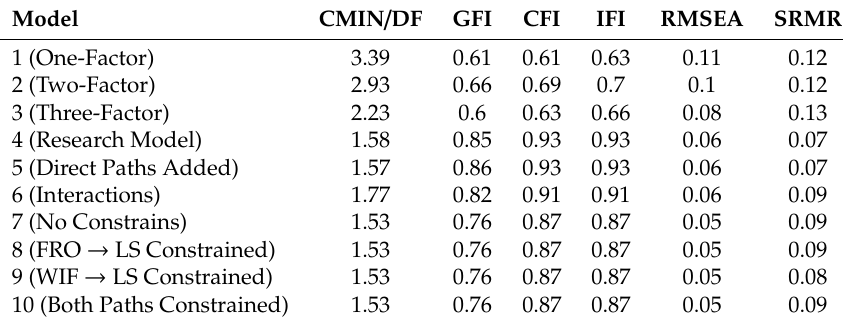
Table 2. Measures of model fit for all estimated models.